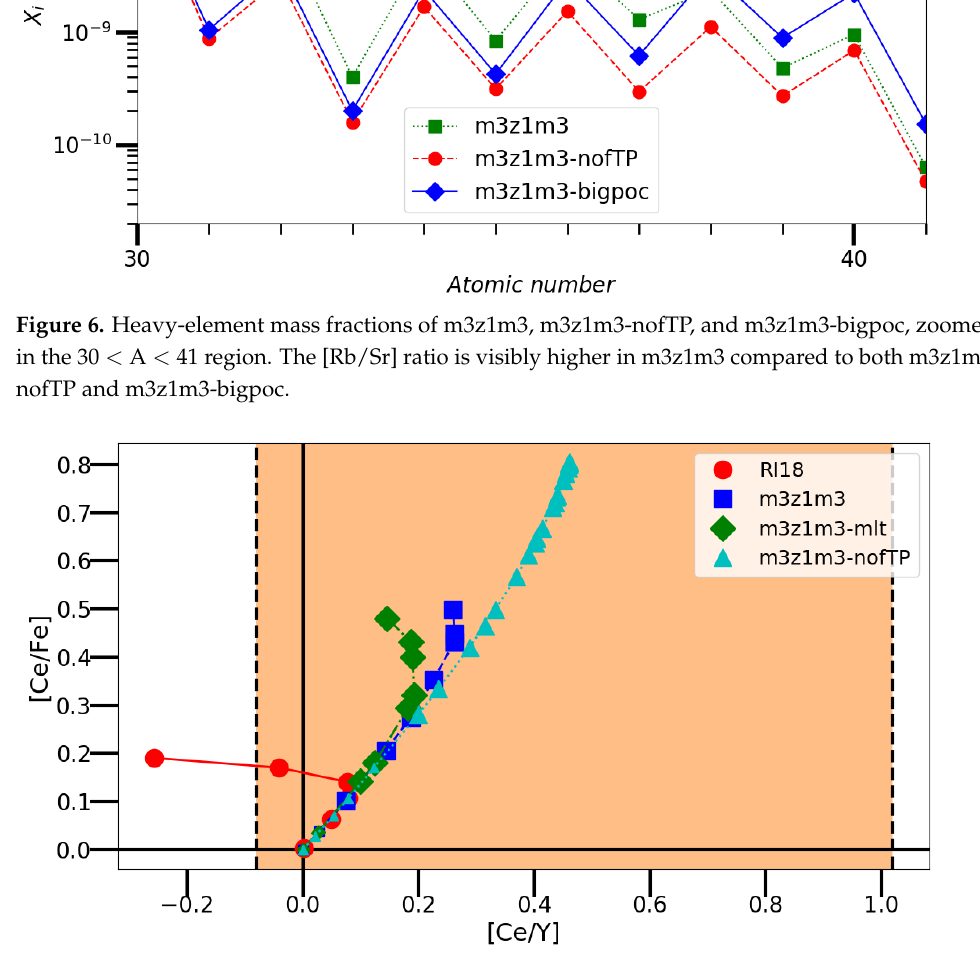
Figure 7. Comparison of [Ce/Fe] vs. [Ce/Y] results from the whole evolution of m3z1m3, m3z1m3- mlt, m31m3-nofTP, and the 3 M (cid:12) model from RI18. The two vertical dashed lines indicate the range within which 80% of low-Z AGB abundance observations are